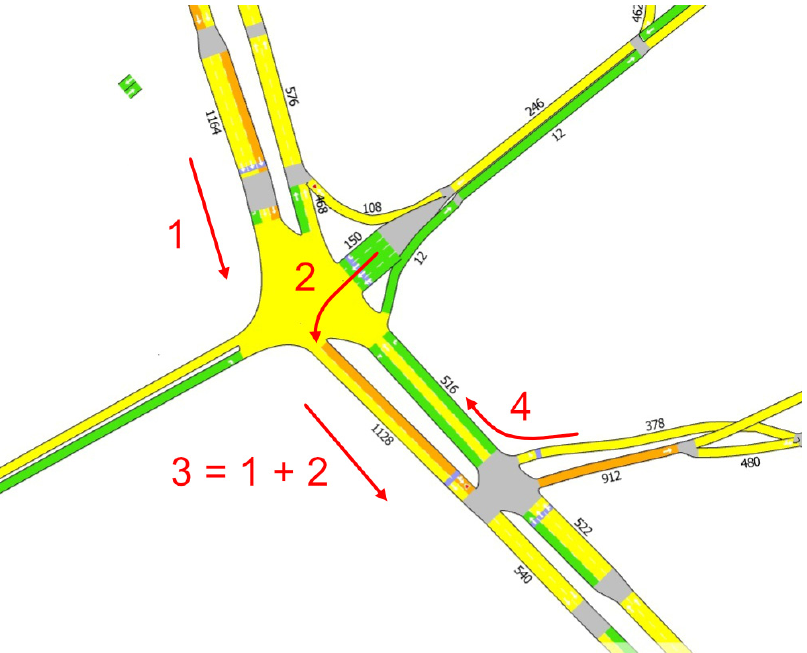
Figure 10. Network of two junctions regulated by traffic lights.